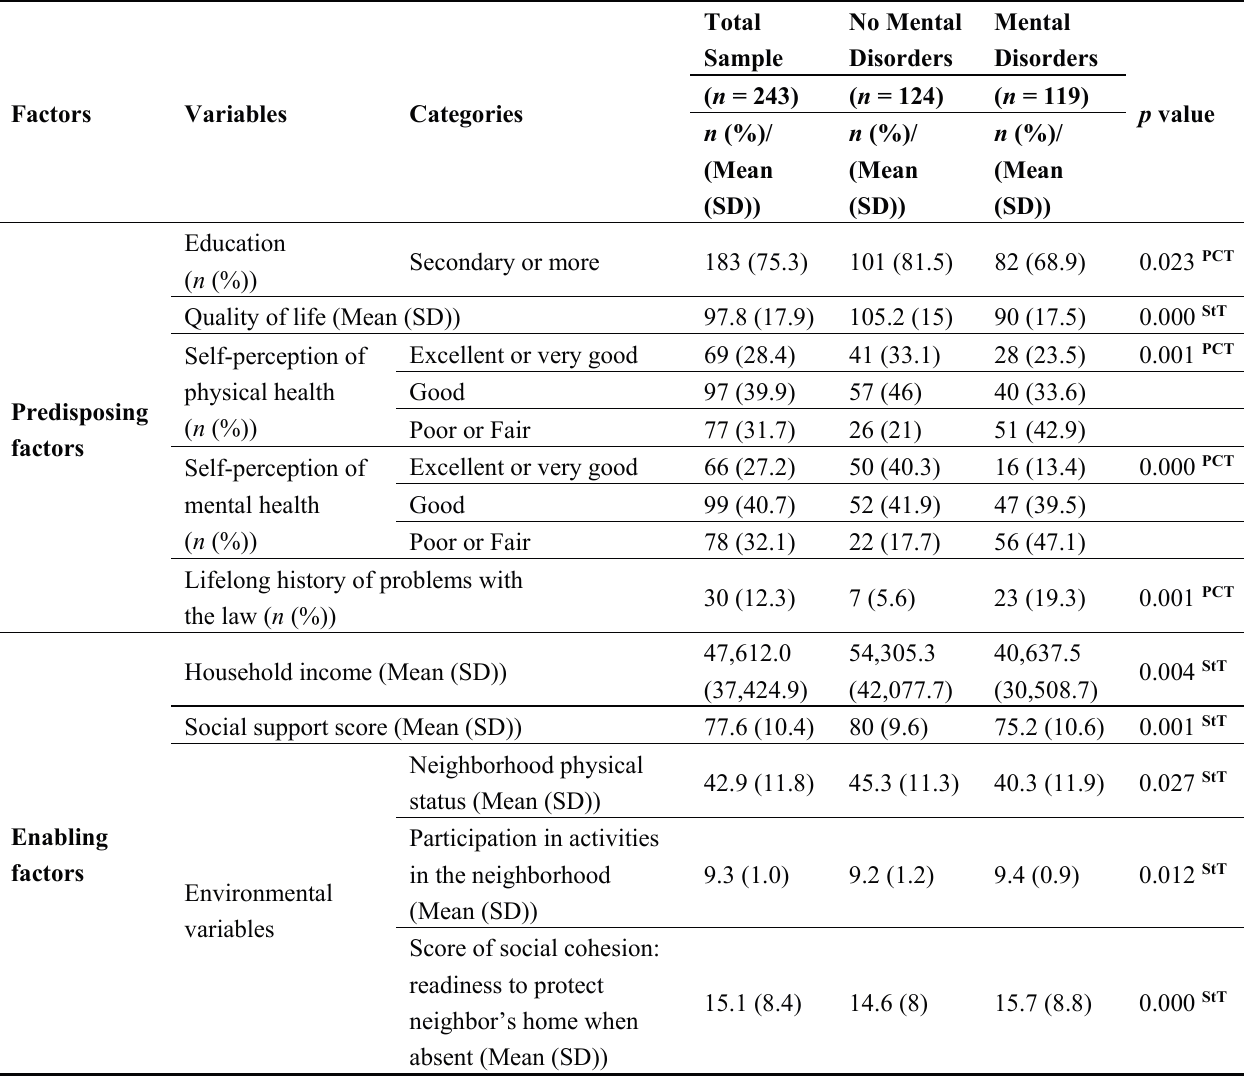
Table 5. Comparative analyses between participants with vs. without mental disorders using mental healthcare services ( n =